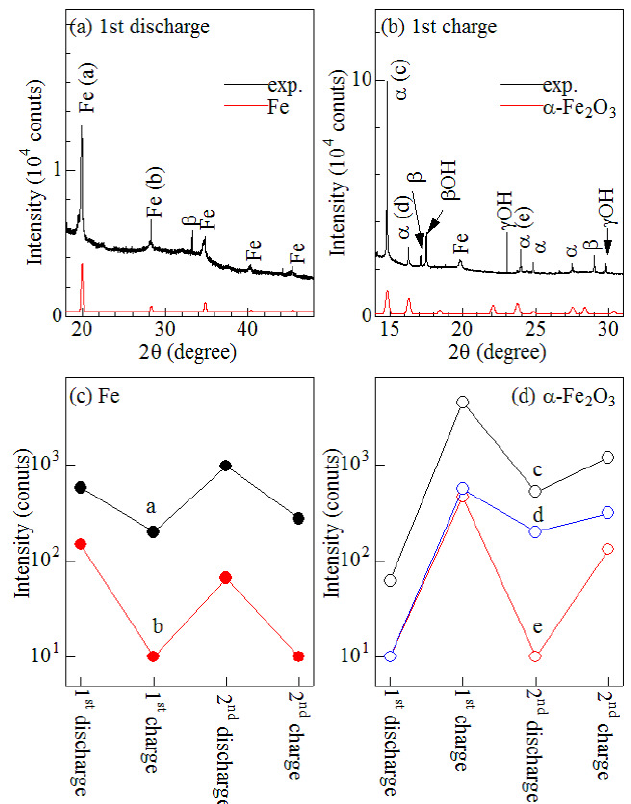
Figure 4. ( a ) XRD pattern of discharged film together with the simulated pattern of Fe; ( b ) XRD pattern of the charged film together with the simulated pattern of α -Fe 2 O 3 . Fe, α , β , β OH and γ OH represent Fe metal, α -Fe 2 O 3 , β -Fe 2 O 3 . β -FeOOH and γ -FeOOH, respectively; ( c ) cycle dependence of the intensities of the Fe peaks; and ( d ) cycle dependence of the intensities of the α -Fe 2 O 3